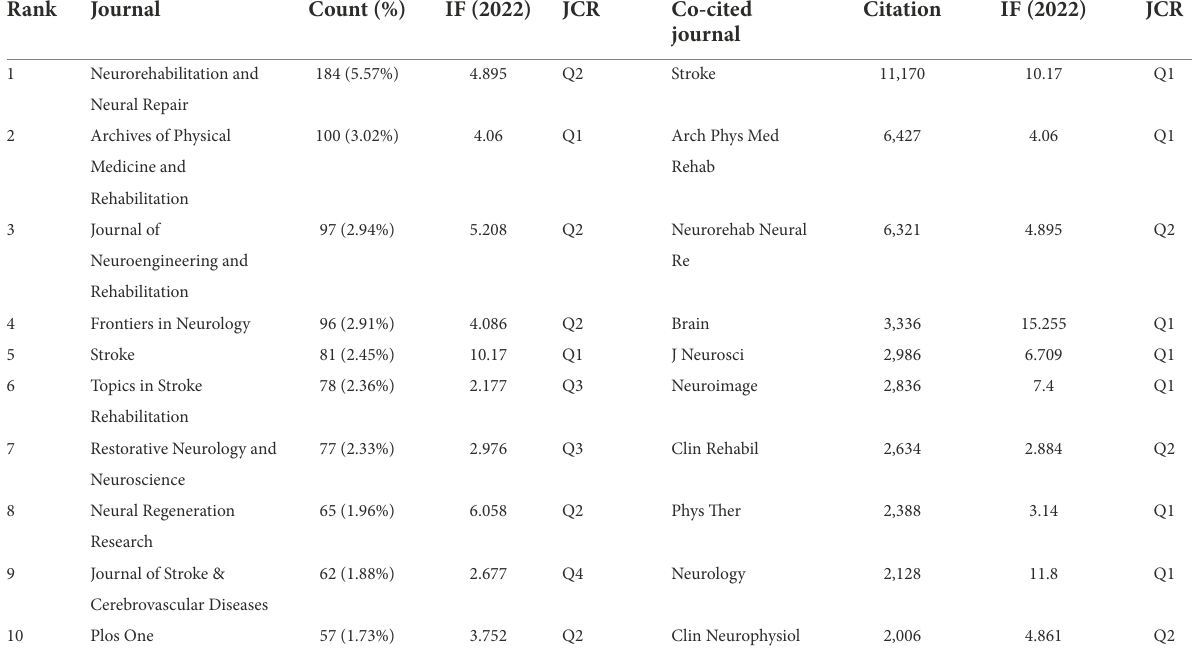
TABLE 3 Top 10 journals and co-cited journals related to stroke motor function